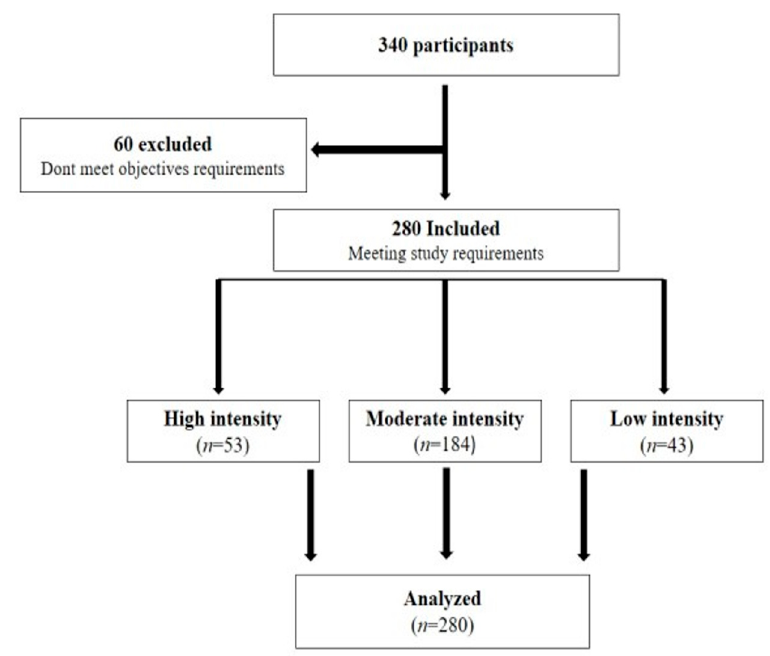
Figure 1. Participation flowchart depending on the intensity of training performed.